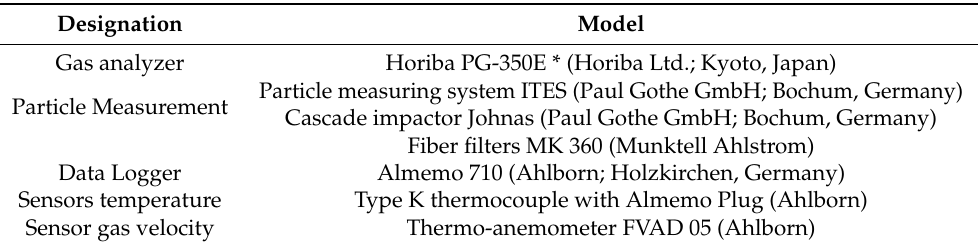
Table 3. Measurement devices used in the experiments. Designation Model Gas analyzer